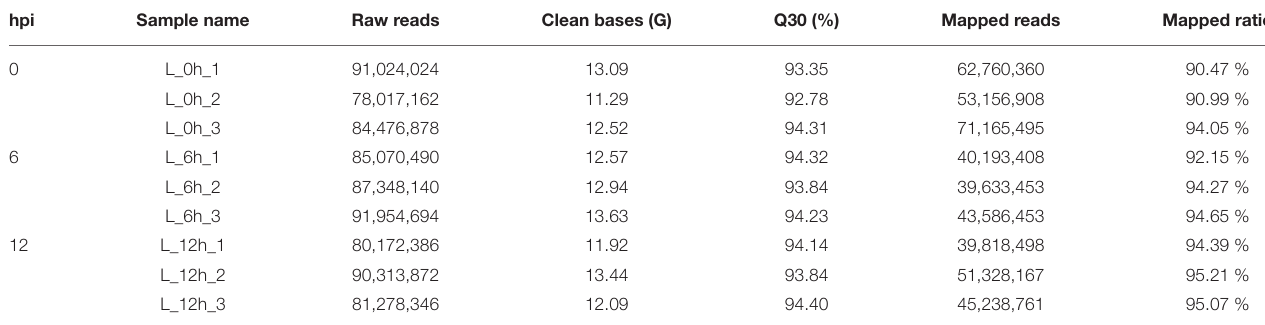
TABLE 1 | Summary of lncRNA sequencing